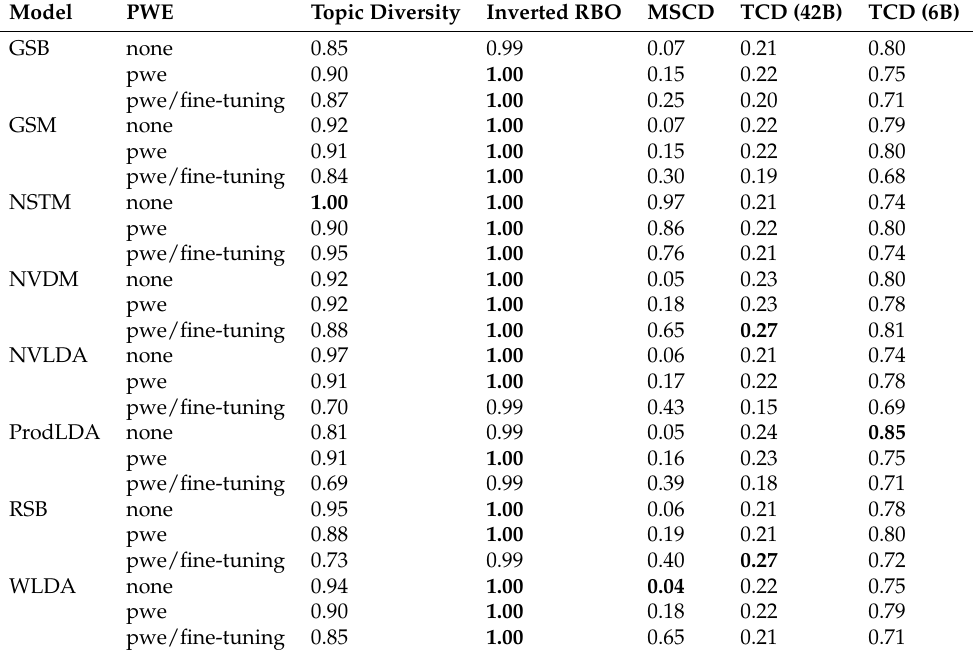
Table 14. Topic Diversity on BBCNews.